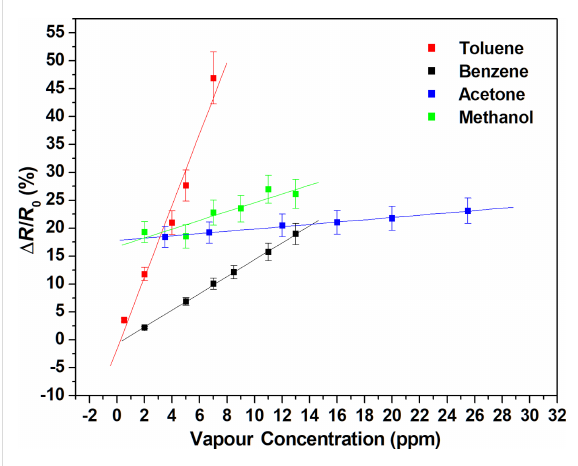
Figure 7: Calibration curves for the HDT/Au-MWCNT sensor for meth- anol and acetone nonaromatic VOC detection.